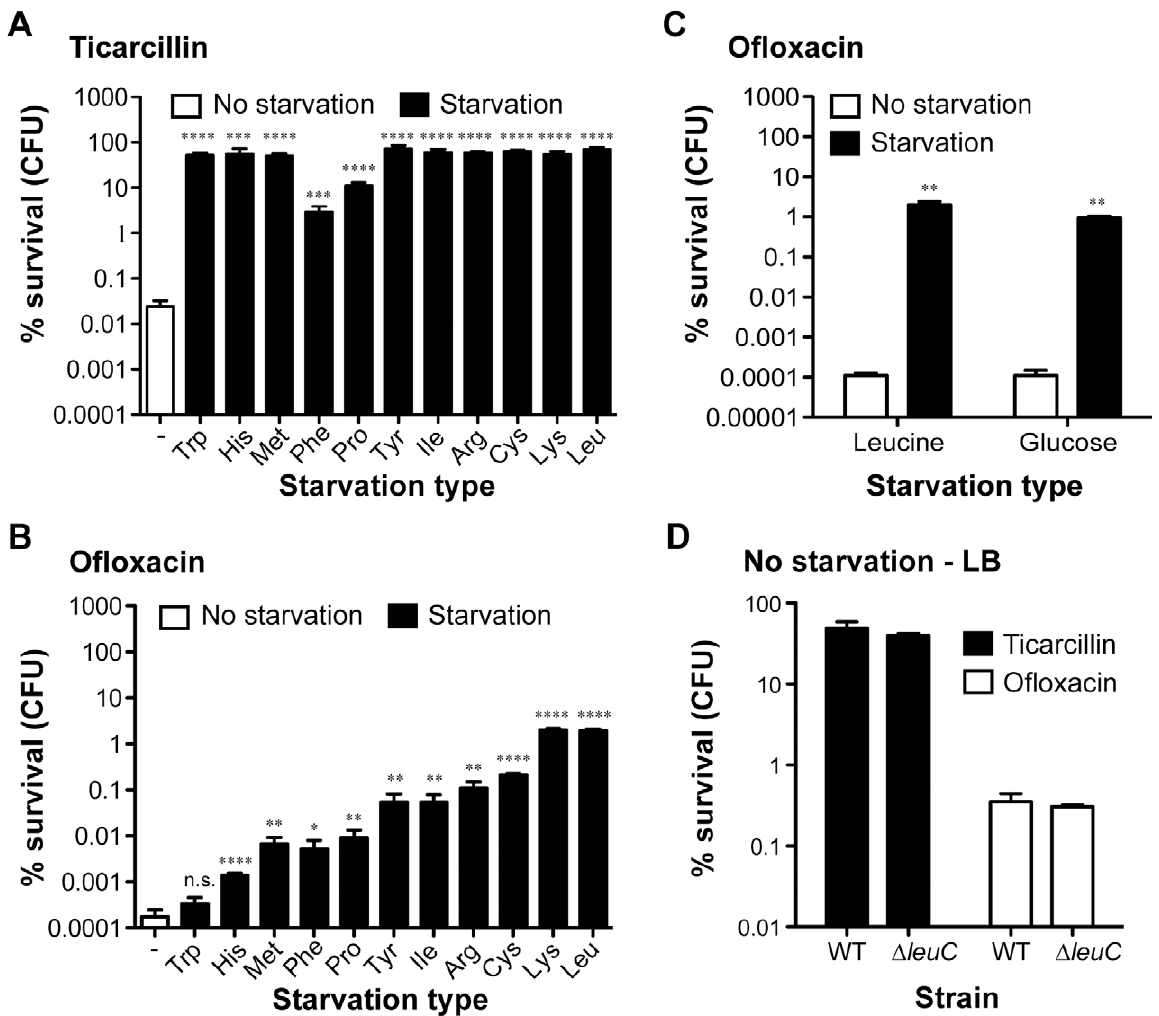
Figure 2. Starvation leads to high antibiotic tolerance in biofilms of E.coli TG1. The tolerance of non-starved biofilms (white bars; wild-type prototroph TG1 (WT)) to (A) ticarcillin (100 m g ml 2 1 , 100 6 MIC) or (B) ofloxacin (5 m g ml 2 1 , 80 6 MIC) was compared to biofilms starved for individual amino acids (black bars; auxotrophic mutants). (C) Addition of exogenous leucine (10 m g ml 2 1 ) or glucose (0.4%) restored ofloxacin sensitivity to biofilms. (D) Antibiotic tolerance profiles of biofilms grown and treated in LB-rich medium were indistinguishable from a leucine auxotroph and its WT prototroph. For panels A to C, biofilms of all tested amino acid auxotrophs were grown in M63B1 Gluc for 24 h with the addition of 25 m g ml 2 1 of the required amino acid, while WT was grown in M63B1 Gluc only. Antibiotic treatments were performed for a period of 24 h on 24-h biofilms. Conditions of starvation during treatment were achieved by removing the required amino acids (M63B1 Gluc ) for the respective auxotrophic strains or glucose for the WT prototroph (M63B1). In panel D, biofilms were grown for 24 h and treated for 24 h in LB-rich medium. Surviving cells were quantified by viable cell counts. Percent survival represents viable cells after 24 h of treatment compared to untreated biofilm prior to addition of antibiotics. All compared biofilms had similar numbers of CFU prior to antibiotic treatment (data not shown). Data represented are means 6 SEM of at least three replicates. Asterisks indicate values significantly different from conditions of no starvation by the two-tailed unpaired t test: * P # 0.05, ** P # 0.01, *** P # 0.001, **** P # 0.001 and n.s. (not significant). The genotypes of all amino acid auxotrophic mutants constructed in the WT prototroph TG1 genetic background are described in Table S1 or as follows: tryptophan (Trp; D trpA ::KmFRT), histidine (His; D hisG ::KmFRT), methionine (Met; D metA ::KmFRT), phenylalanine (Phe: D pheA ::KmFRT), proline (Pro: D proC ::KmFRT), tyrosine (Tyr; D tyrA ::KmFRT), isoleucine (Ile; D ilvA ::KmFRT), arginine (Arg; D argH ::KmFRT), cysteine (Cys; D cysD ::KmFRT), lysine (Lys; D lysA ::KmFRT), and leucine (Leu: D leuC ::GB).